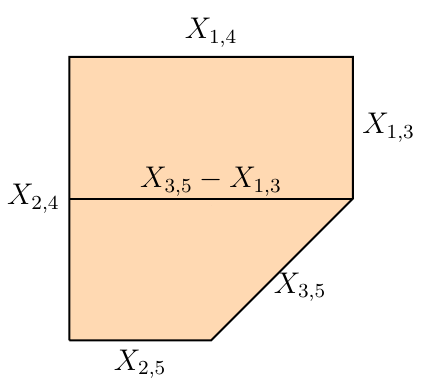
Figure 6 . A visualization of the (partial) triangulation of A 5 [1 , 2 , 3 , 4 , 5] corresponding to the single variable